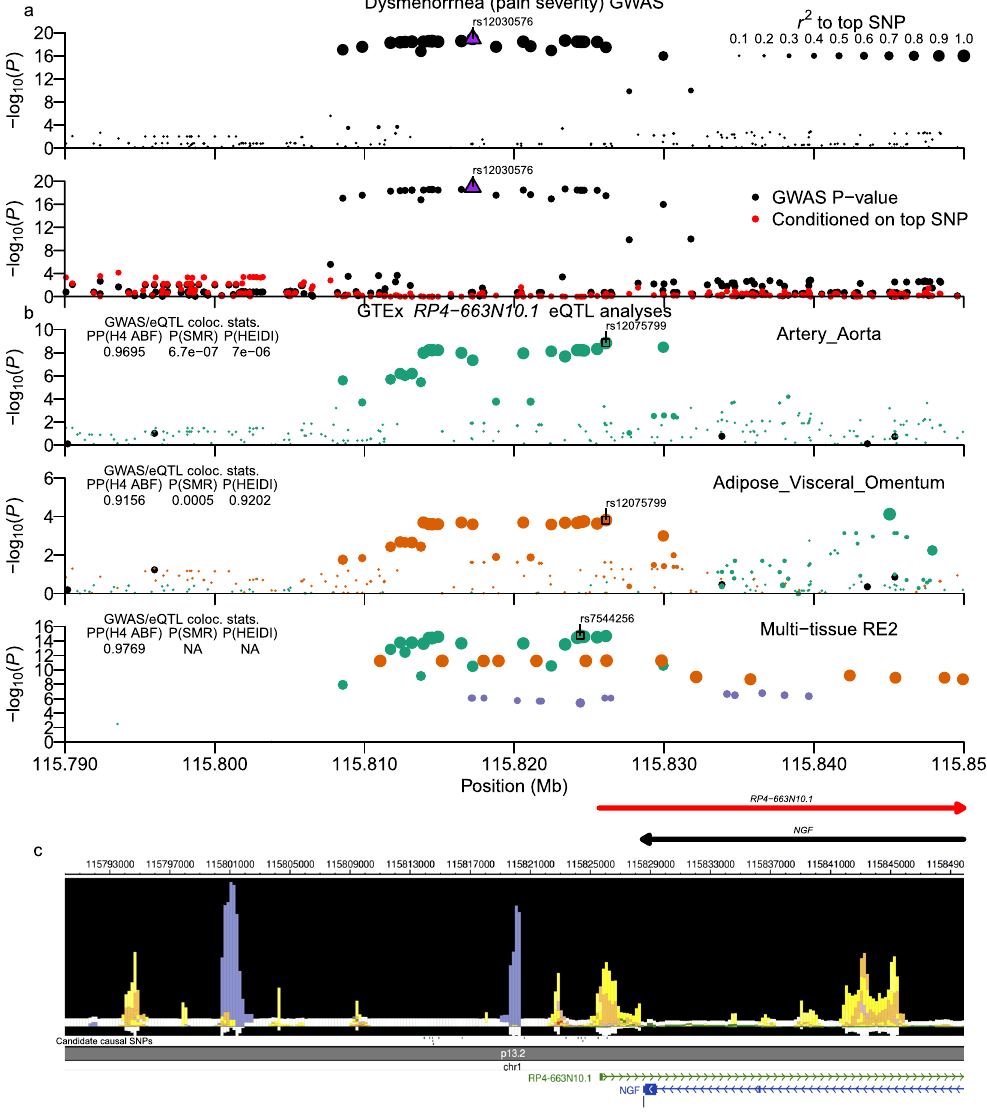
Figure 3. Dysmenorrhea (pain severity) chr1:115.80–115.83 Mb ( NGF ) locus. Plot is configured the same as Fig. 1. ( b ) shows GTExPortal lncRNA gene RP4-663N10.1 eQTL data. ABF colocalization analysis of